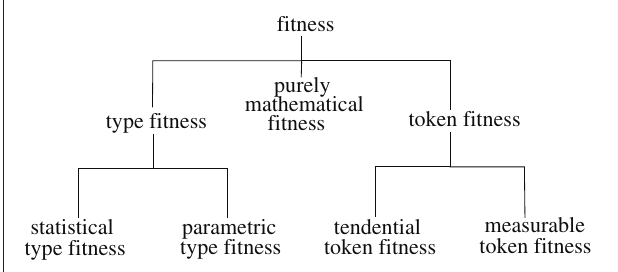
FIGURE 1 | Classes of fitness concepts defined in the text. Lines connect classes to their